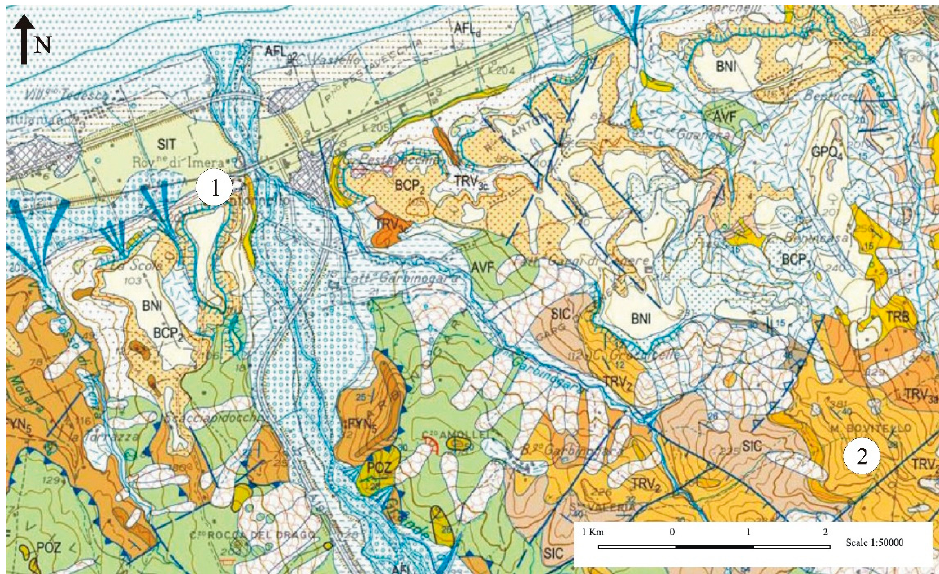
Figure 5. Geological map of the area of Himera (simplified after [25]). Sites 1 and 2 (circled) correspond to the Himera archaeological site and Mt Bovitello, respectively. Codes of Formations that outcrop in the territory of Himera are provided here: AFL = Synthem of Capo Plaia (Upper Pleistocene-Holocene); SIT = Synthem of Barcarello (Pleistocene); BNI = Synthem of Benincasa (Upper-Middle Pleistocene); BCP = Synthem of Buonfornello-Campofelice (Middle Pleistocene); TRB = Trubi (Zanclean), GPQ4 = Pasquasia Formation (Lower Messinian); TRV = Terravecchia Formation, namely TRV3 (a-b-c) is the Pelitic member, while TRV2 is the sandstone one (Upper Tortonian-Lower Messinian); SIC = Castellana Sicula Formation (Serravallian-Lower Tortonian); POZ = Polizzi Formation (Upper-Middle Eocene); AVF = Argille Varicolori Inferiori (Upper Cretaceous − Paleocene); FYN5 = Numidian Flysch (Upper Oligocene-Lower Miocene). The full legend is accurately reported in